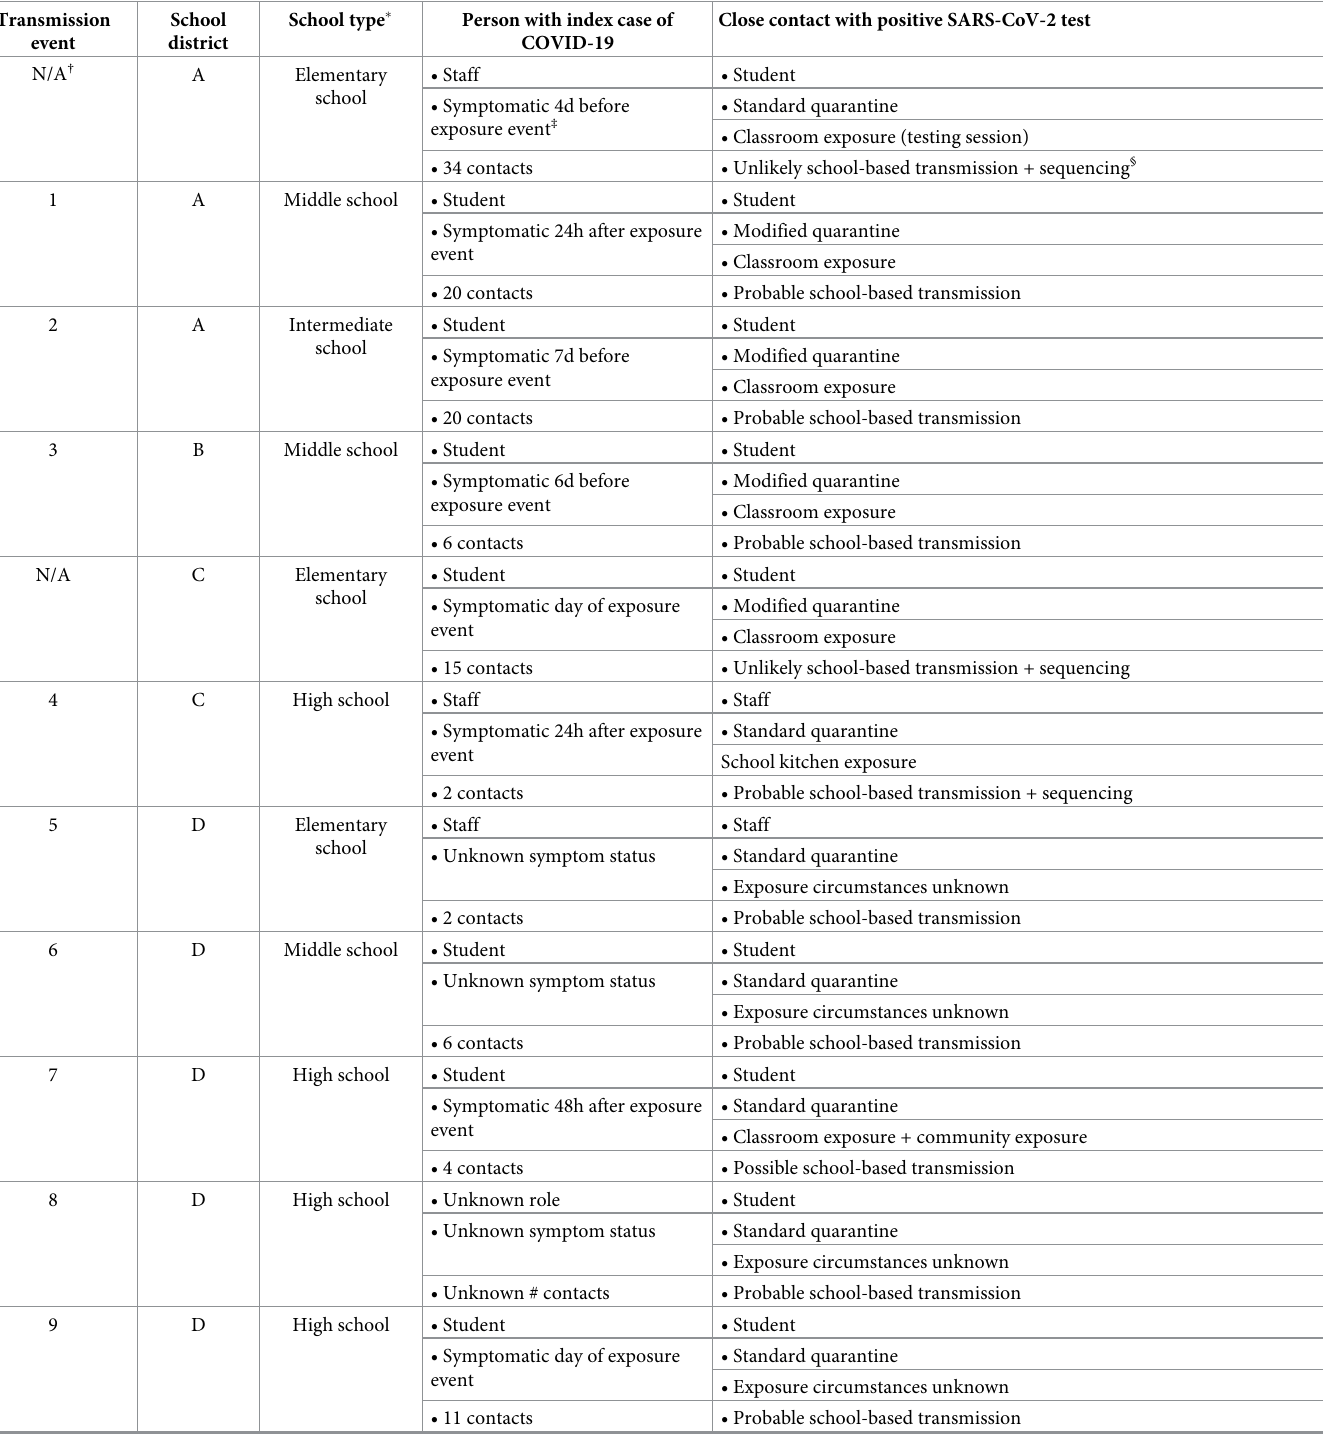
Table 2. Characteristics of school-based persons with index cases of COVID-19 and close contacts who received a positive SARS-CoV-2 test result from K–12 schools, Greene and St. Louis Counties, Missouri, January 25–March 21, 2021. Transmission